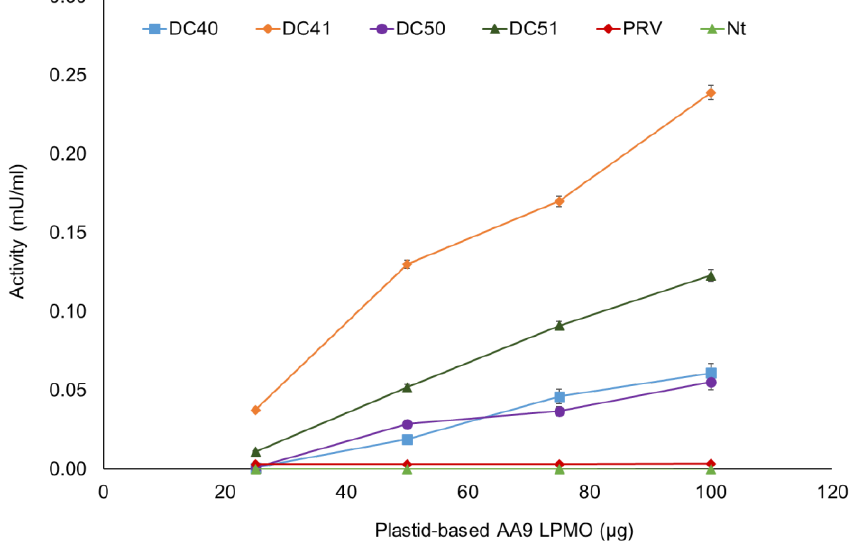
Figure 7. Profile of LPMO activity (mU/mL) of crude protein extracts from transplastomic and control plants. Assayed amounts of plastid-based AA9 LPMOs (25–100 µ g) were estimated by Western blot analysis. All data are expressed as mean values ( ± SD), from three independent biological/technical replicates.